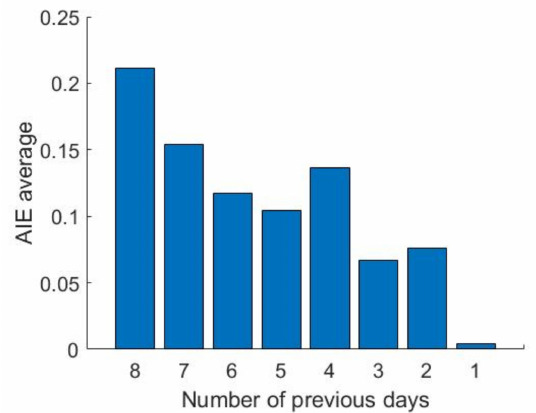
Figure 5. AIE average of previous days at 9:00